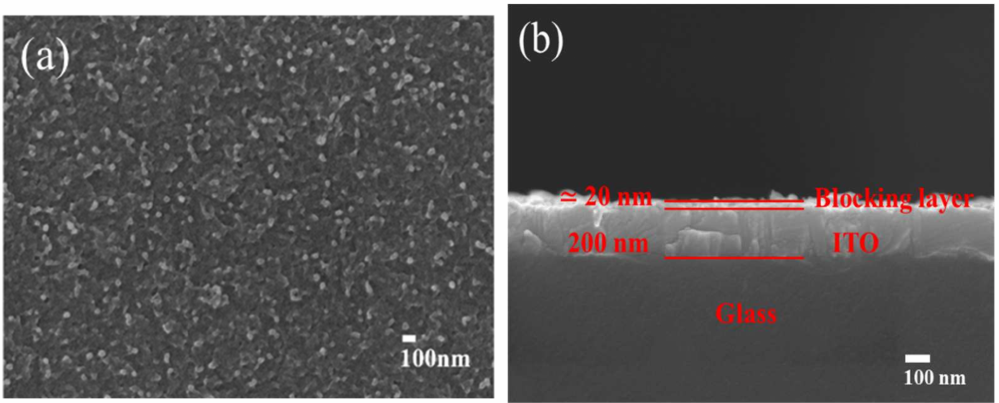
Figure 2. SEM images of the TiO 2 blocking layer coated on ITO/glass ( a ) plan-view ( b ) cross-section.